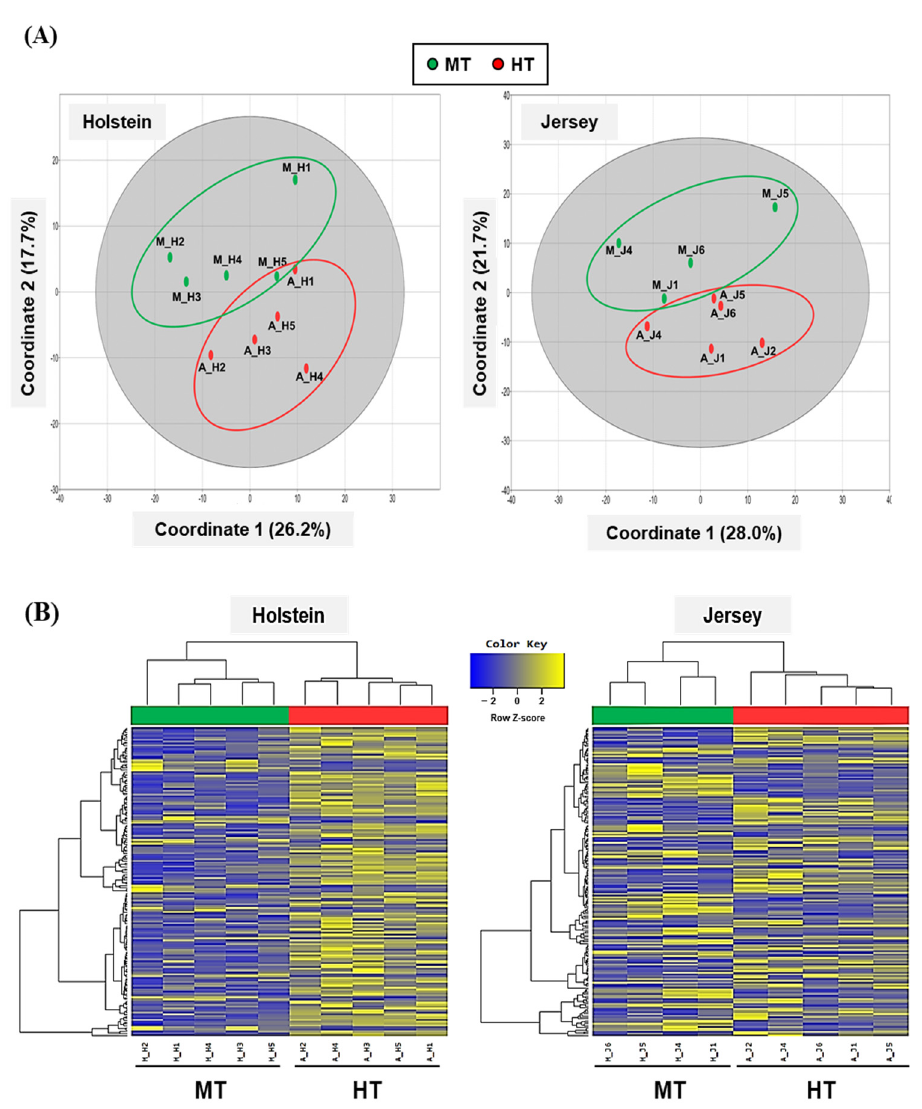
Figure 2. Differentially expressed genes in PBMCs of different breeds of dairy cow in different THI conditions. Principal coordinate analysis (PCoA) plots ( A ) and hierarchical clustering ( B ) of DEGs in PBMCs of Holstein and Jersey cows. MT, moderate THI season; HT, high THI season.